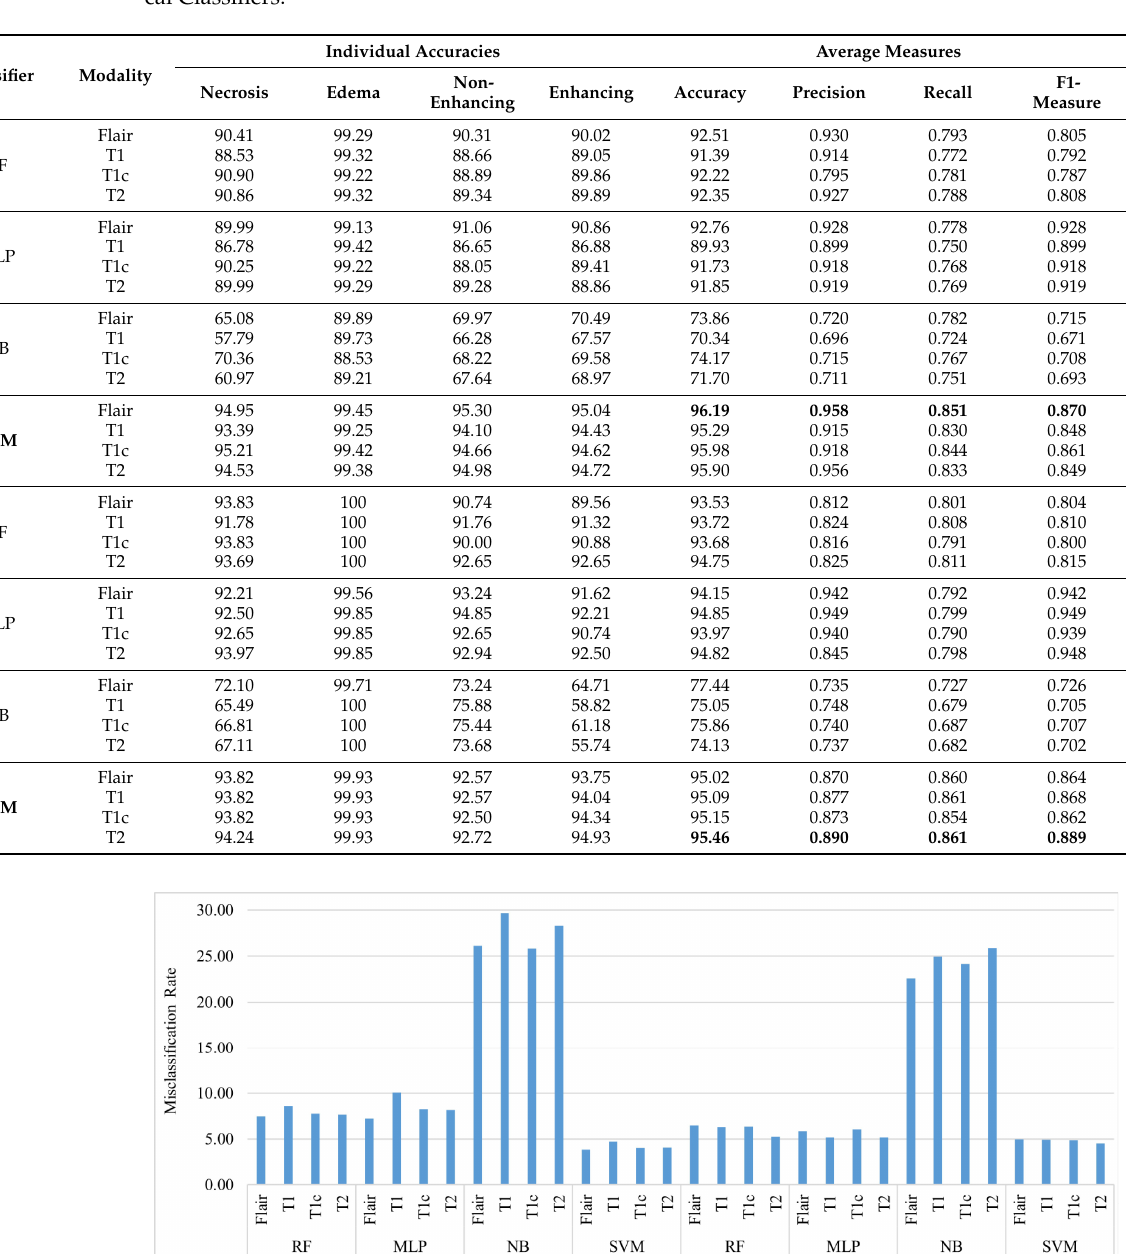
Figure 2. Comparison of the average misclassification of four Glioma Tumor classes using different